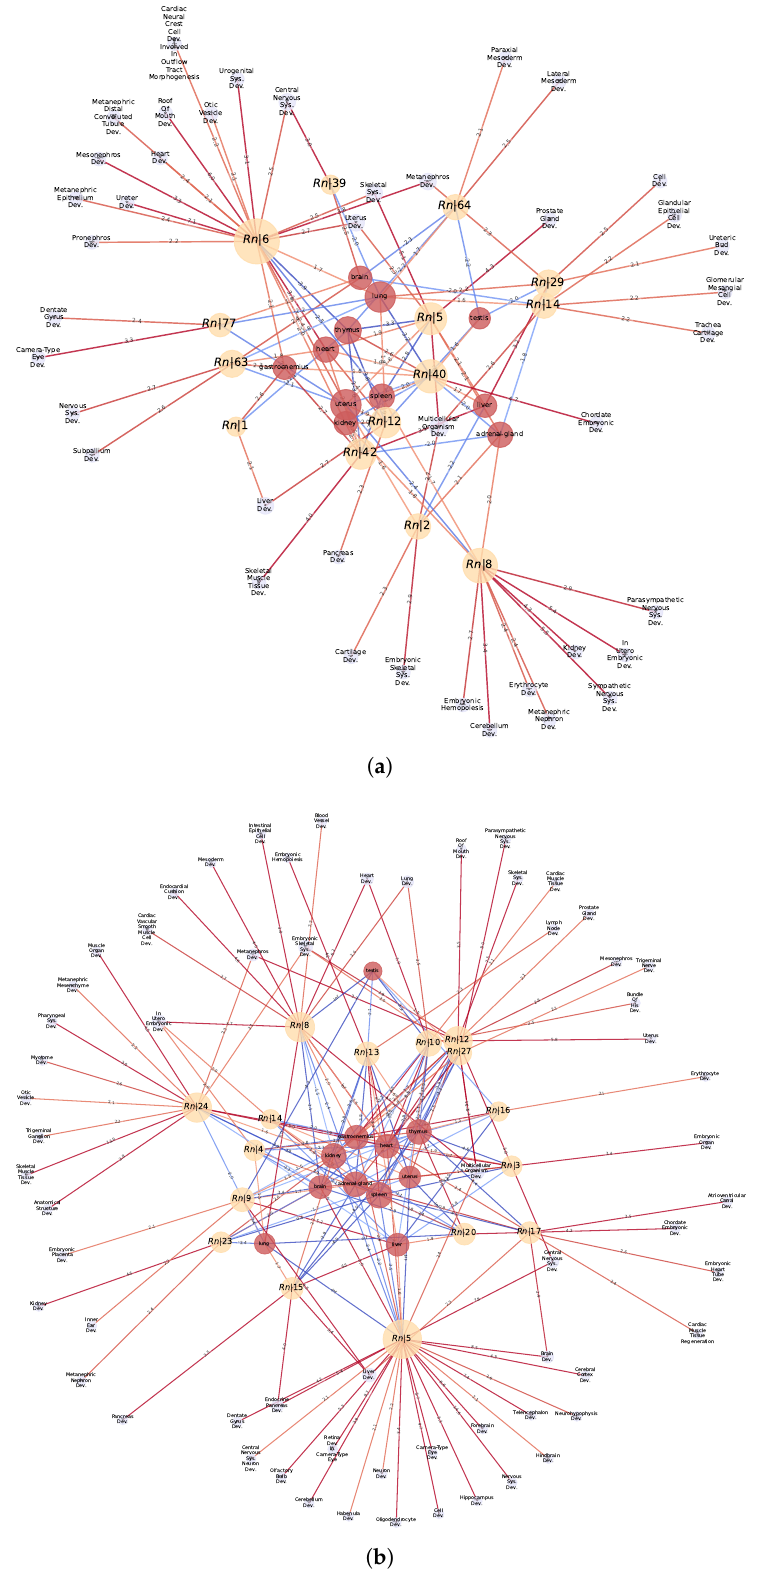
Figure 8. Statistically significant Normalized Enrichment GSEA Scores between cell-types (red nodes) and GXN•OMP and GXN•EN GRN communities (yellow nodes), and statistically significant associations between GO terms (blue nodes) and GXN•OMP and GXN•EN communities, for the R. norvegicus dataset; ( a ) GXN•OMP- R. norvegicus ; ( b ) GXN•EN- R. norvegicus